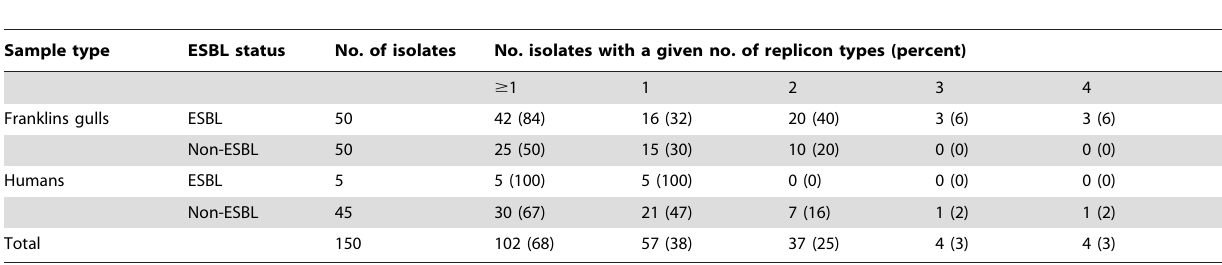
Table 3. Total prevalence and the number of distinct replicon types identified in the MLST-subset of isolates from Franklins gulls and humans.